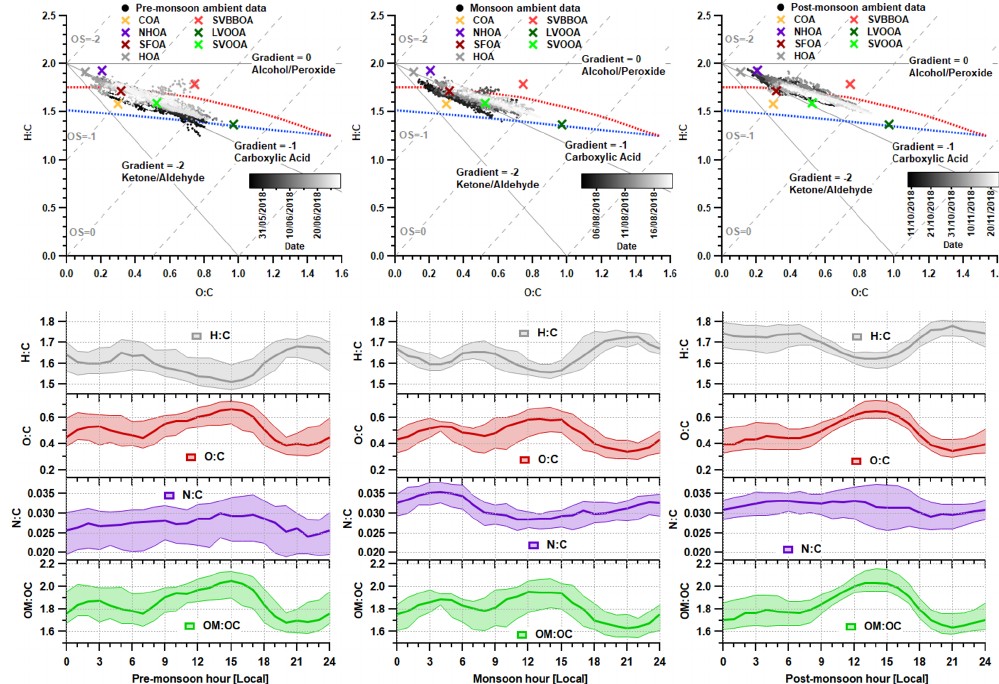
Figure 11. Van Krevelen (VK) diagrams and median diurnal cycles for elemental ratios during each measurement period. Each VK diagram contains the H:C vs O:C data for the PMF solutions and the raw AMS measurements which are coloured based on the time of the measure- ment. The carbon oxidation states (OS C ≈ 2O / C − H / C) are shown using grey dashed lines, and the functional group gradients are shown using solid grey lines. The blue and red dashed lines demarcate the region where published ambient OOA measurements are commonly found (Ng et al., 2011).